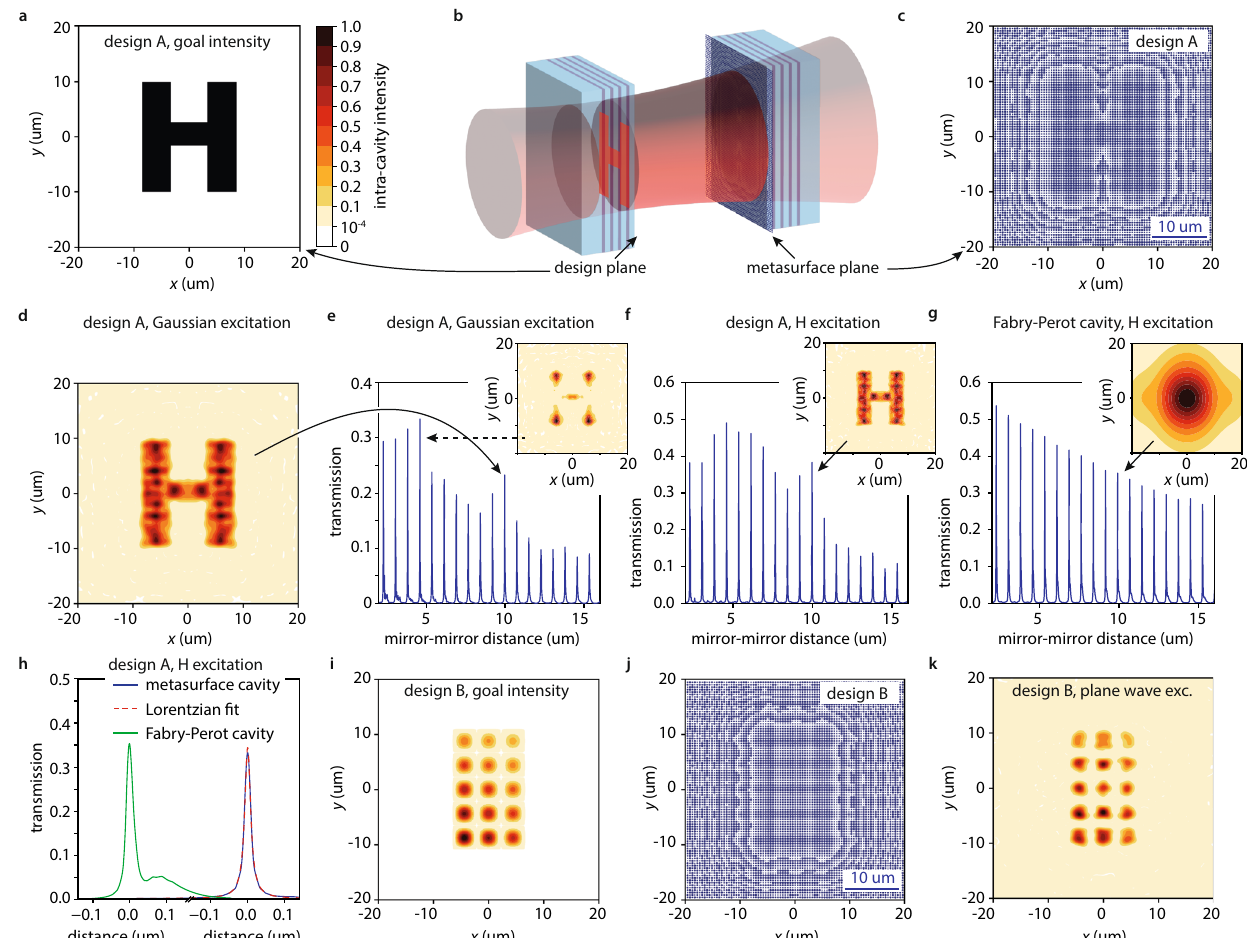
Fig. 5 | Metasurface microcavities with designer mode pro fi les. a desired transversecavitymodeintensitypro fi leinthedesignplane(designA,thecolorbar is valid for all panels). x , y are the transverse spatial coordinates. b cavity setup: a light beam(red) is coupled to a cavity through a planar distributed Braggre fl ector (DBR).AmetasurfaceontheopposingDBR(labeledmetasurfaceplane)isdesigned tosatisfythecavityroundtripconditionforachosenintensitypro fi le(redH-shape) inthedesignplane. c topviewofthecalculatedmetasurfacedesign(designA,blue: pillars). d modeled mode pro fi le in the design plane of a metasurface microcavity using design A illuminated with a Gaussian beam. Only the designed H-pro fi le is enhanced. e modeled (blue line) cavity length-dependent transmission of a meta- surface microcavity using a design A metasurface excited by a Gaussian beam. We observealocalmaximumofthetransmissionpeak(solidblackarrow)atthedesign length(modepro fi leinpanel( d) ).Inset:themodepro fi lefarfromthedesignlength